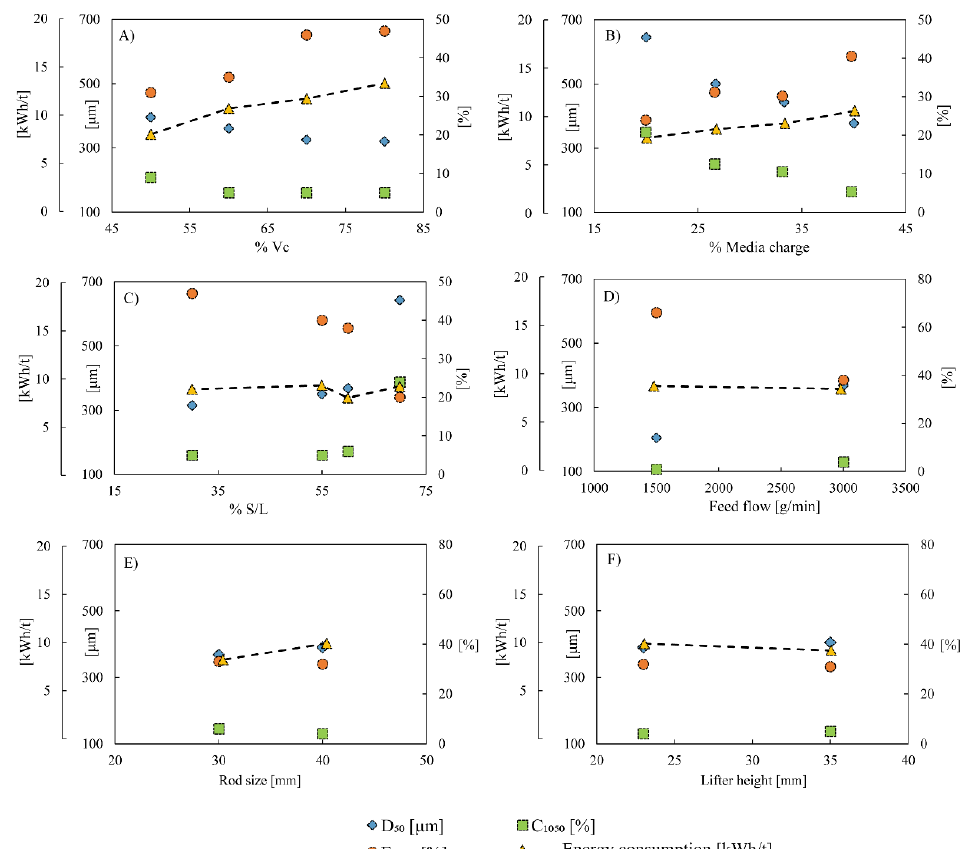
Figure 7. Experimental results, where energy consumption and D 50 parameter are on the left axis, while F 300 and C 1050 parameters are on the right axis, when ( A ) critical rotational speed is varied, ( B ) media charge is varied, ( C ) solid/water ratio is varied, ( D ) feed flow rate is varied, ( E ) rod size is varied, and ( F ) lifter geometry is varied .